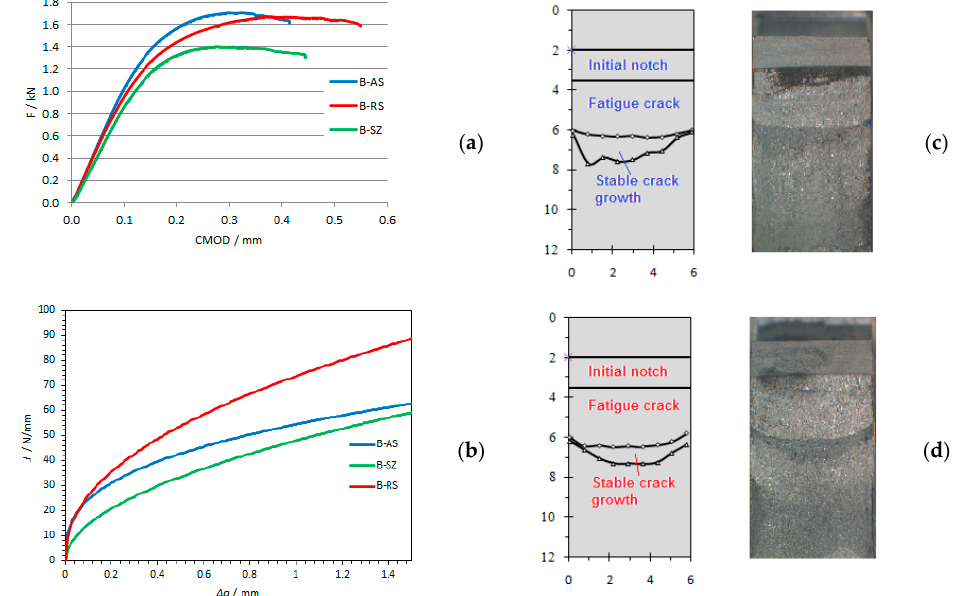
Figure 9. ( a ) Experimental data of load-displacement for specimens for welding speed v = 116 mm/min; ( b ) comparisons of J-R curves for specimen B-AS, B-RS and B-SZ; ( c ) crack surfaces on retreating side (RS) for specimen B-AS; ( d ) crack surfaces on retreating side (RS) for specimen B-RS. (B-AS—specimen for welding speed 116 mm/min (B)—notch position 4 mm from center of weld on advancing side (AS); B-RS—welding speed 116 mm/min (B)—notch position 4 mm from center of weld on retreating side (RS); B-SZ—welding speed 116 mm/min (B)—notch position in center of weld